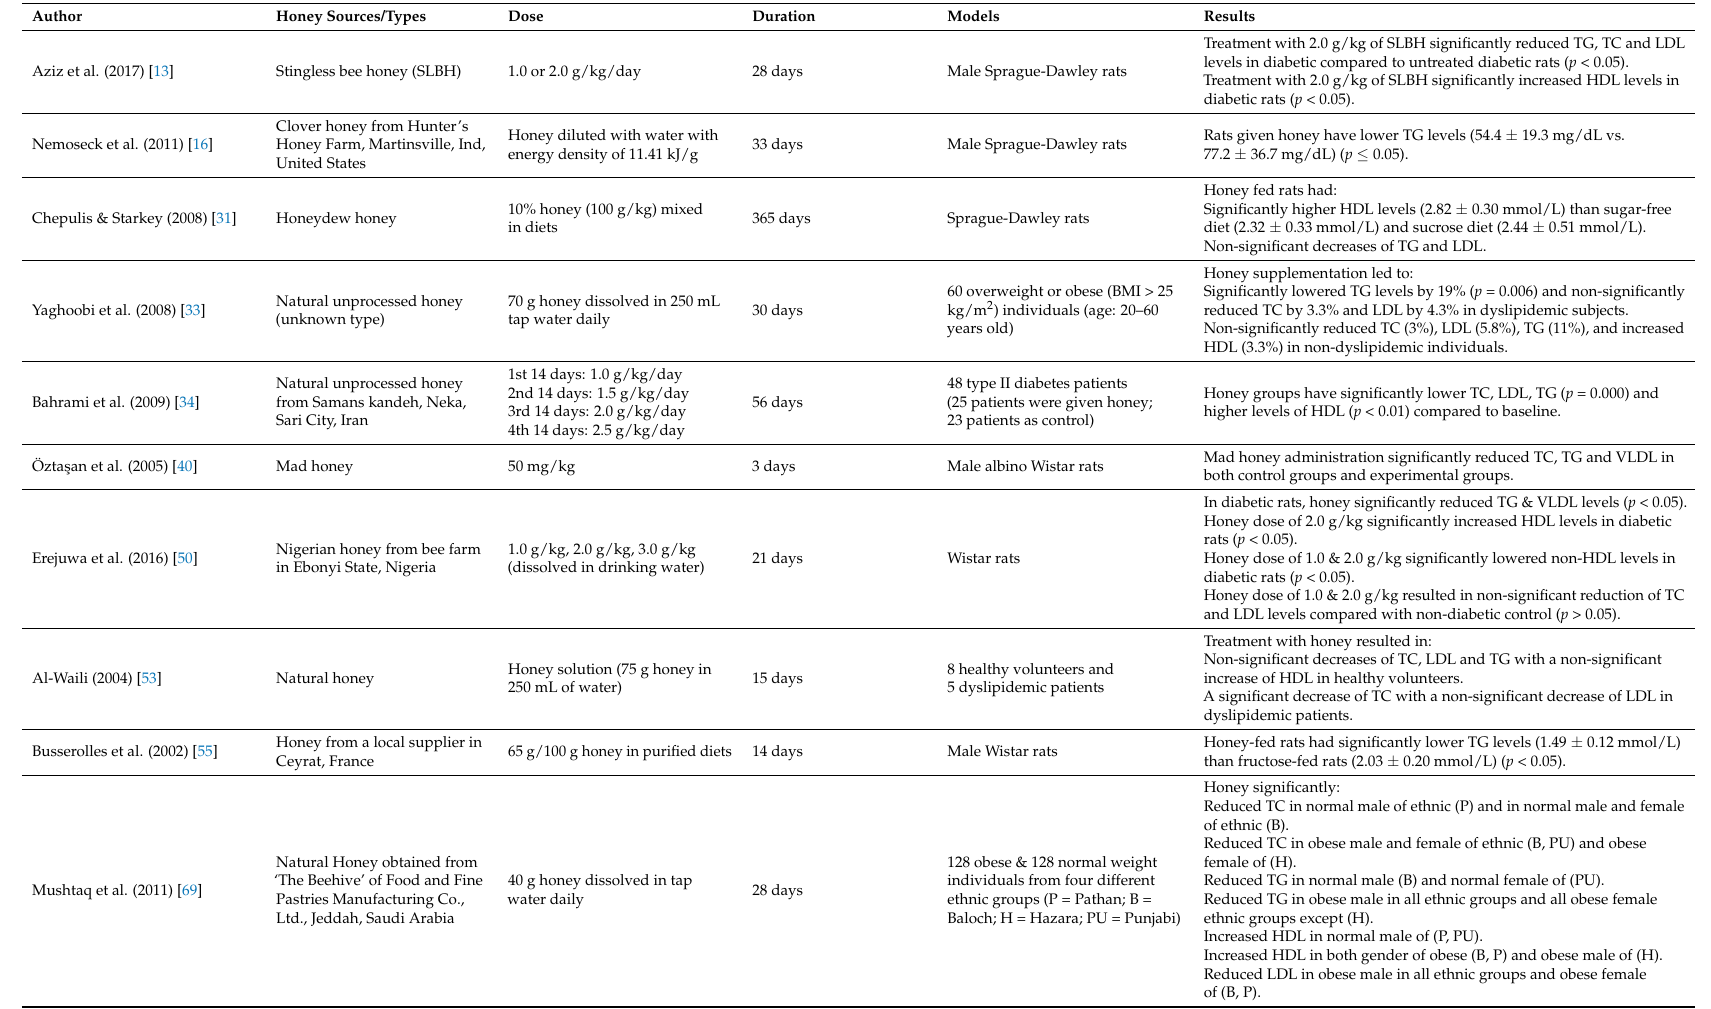
Table 3. Hypolipidemic effects of honey in clinical and pre-clinical